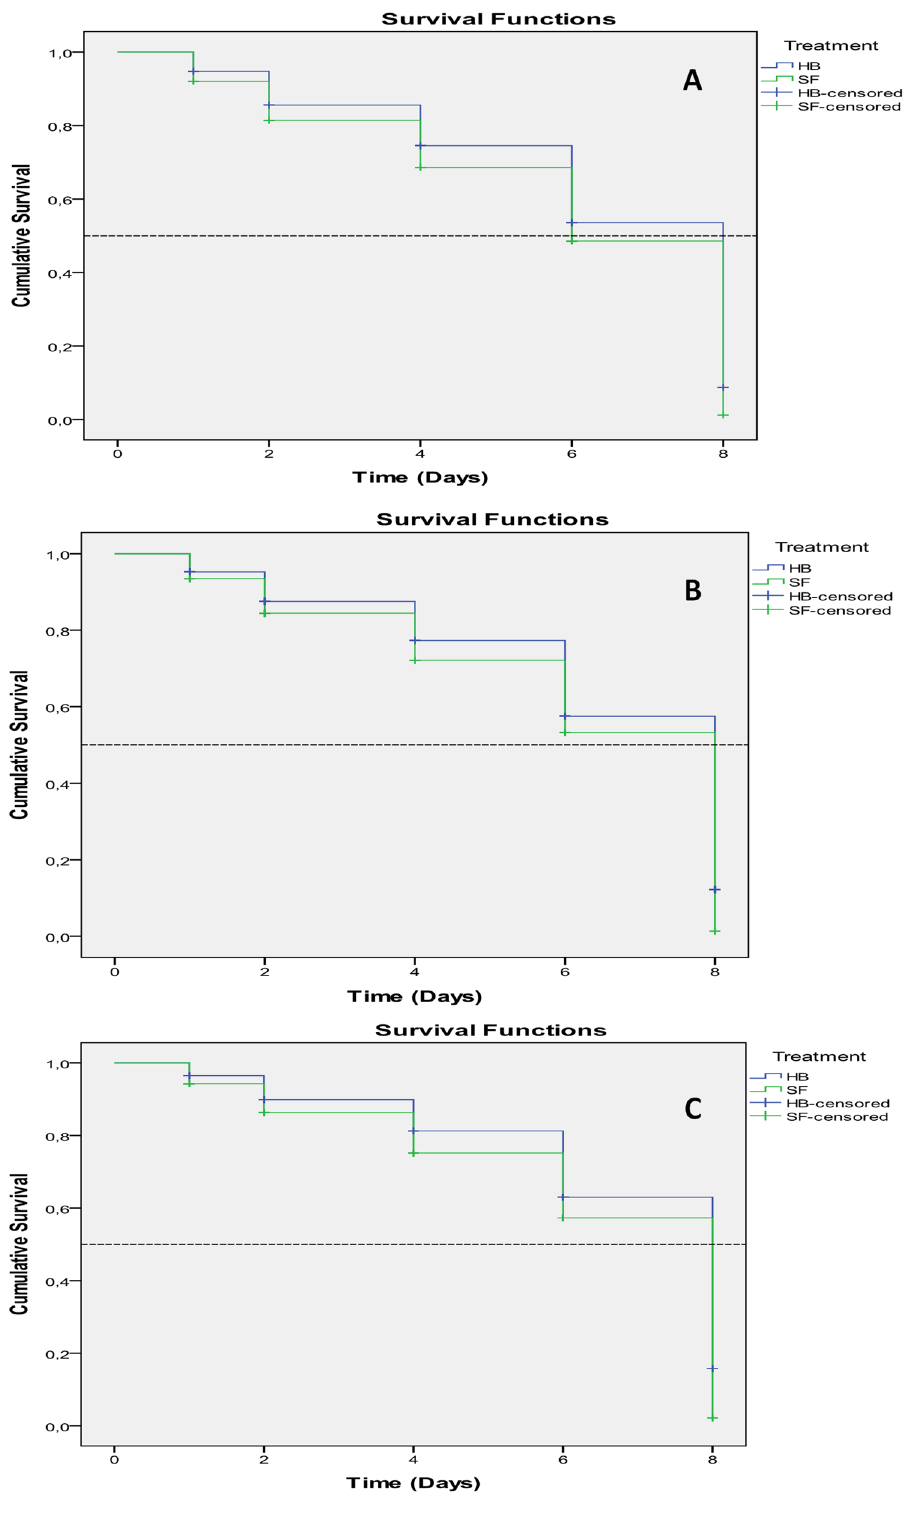
Figure 7. Survival curves (Lethal time LD 50 ) of Dactylopius opuntiae nymphs treated by different concentrations of the two EPNs: ( A ) 75 IJs cm −2 , ( B ) 50 IJs cm −2 , ( C ) 25 IJs cm −2